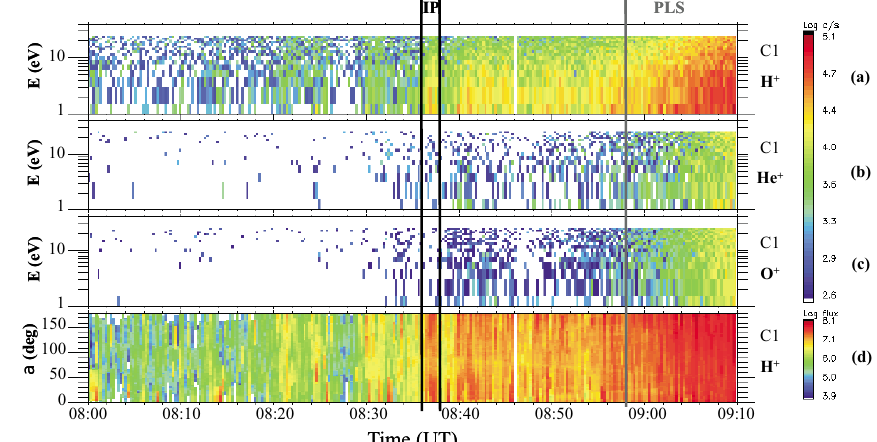
Fig. 4. Energy-time spectrograms from the CIS instrument in RPA mode on 7 May 2002 during the inbound crossing by C1 (IP means “Inbound Plume”; PLS means “Plasmasphere”). Panels (a) , (b) and (c) are for H + , He + and O + ions respectively, and panel (d) is the pitch-angle distribution of H + .